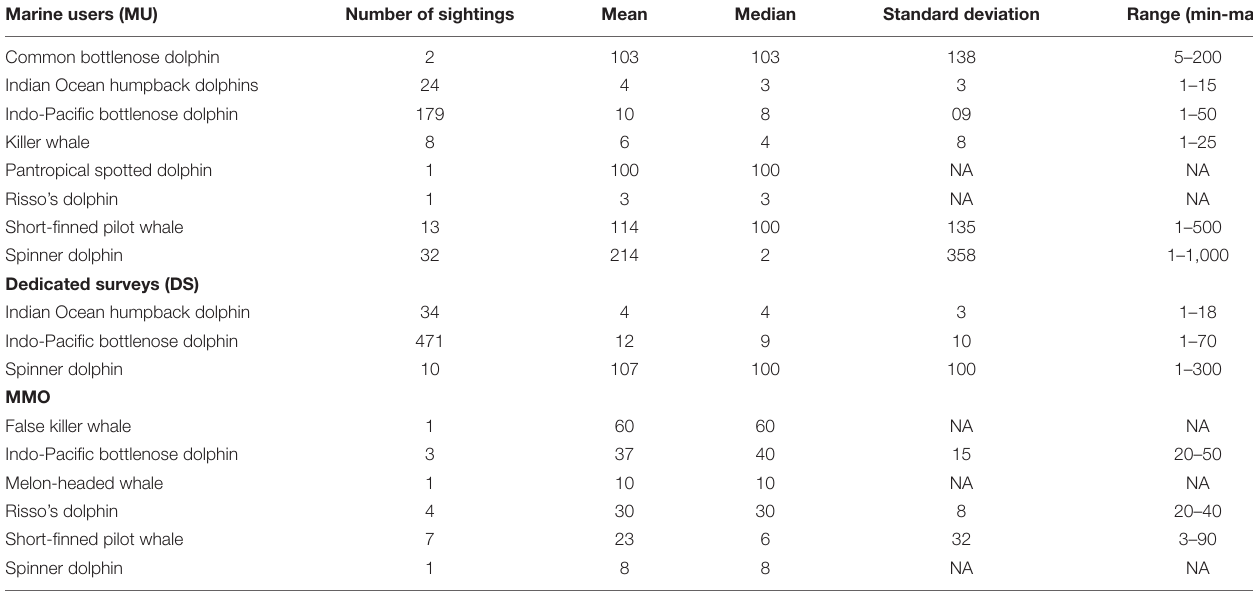
TABLE 2 | Number of sightings, mean and median group size, standard deviation and range per species and data collection method. Marine users